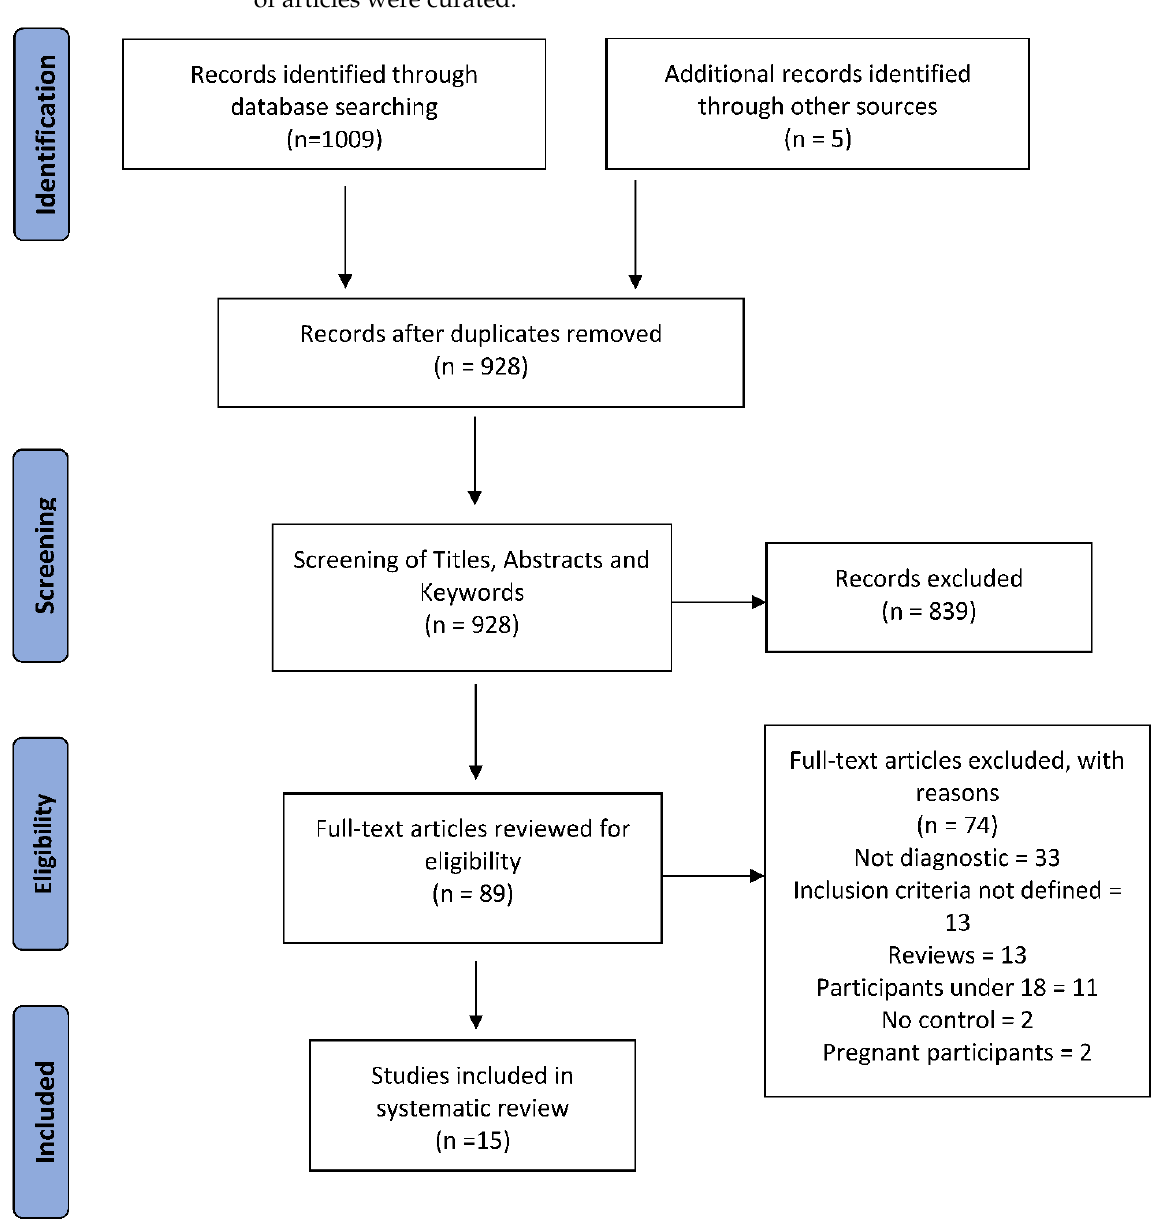
Figure 1. PRISMA diagram illustrating the method of article review and selection for inclusion in this systematic review. n , Number of articles included.